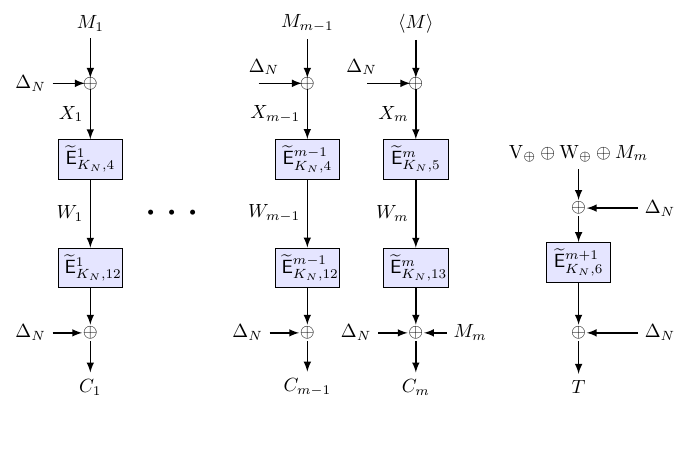
Figure 3: Processing of an m block message M and tag generation for LOCUS . h len i n is used to denote the n bit representation of the size of the final block in bits. W ⊕ denotes the intermediate checksum value and V ⊕ denotes the AD checksum value. e E i in a similar manner as in Fig.